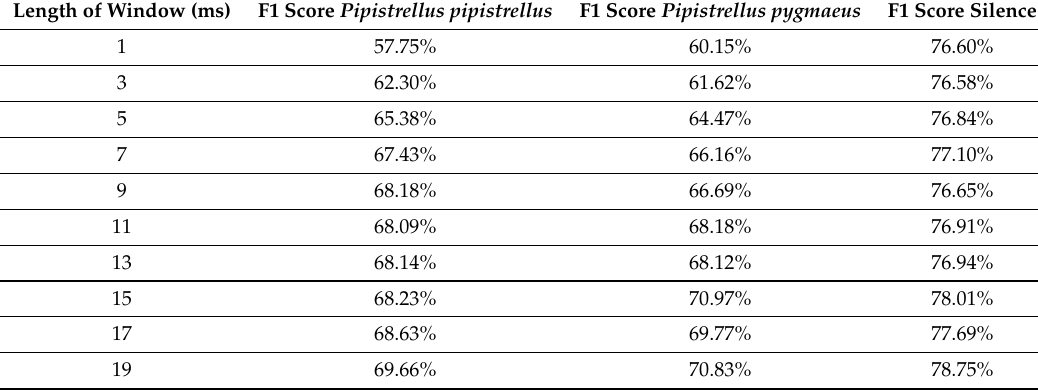
Table 3. Length of the temporal frames with which the data were parameterized and the obtained overall F1